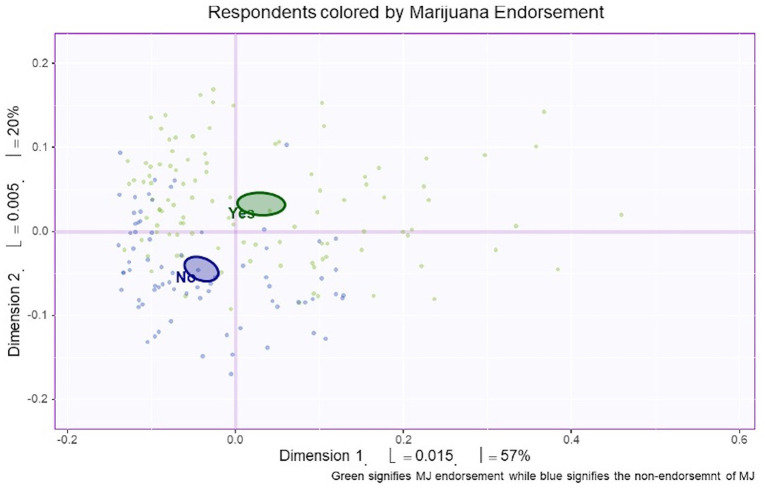
Bootstrap confidence interval comparisons between CBD users with and without marijuana co-use. Mean confidence intervals were created from the bootstrap resampling. Respondents were classified according to endorsement of marijuana use. Based on this figure, dimension 1 (the horizontal line) and dimension 2 (the vertical line) separated CBD users with (green) and without (purple) concurrent marijuana use.